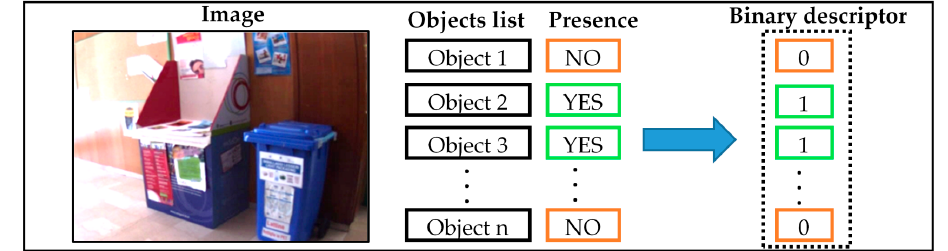
Figure 1. Binary descriptor construction for a training image.